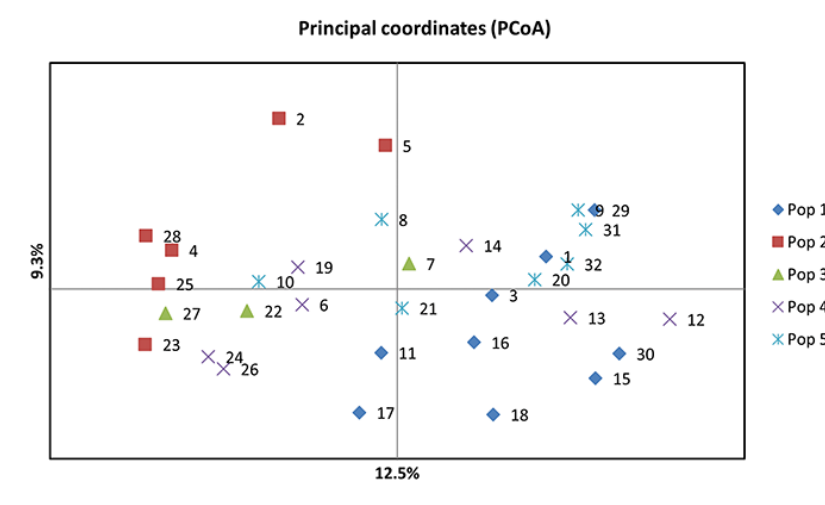
Figure 3 Principal coordinates analysis (PCoA) of 32 barley accessions. Coordinate 1 (12.5%) and Coordinate 2 (9.3%) refer to the first and second principal component,